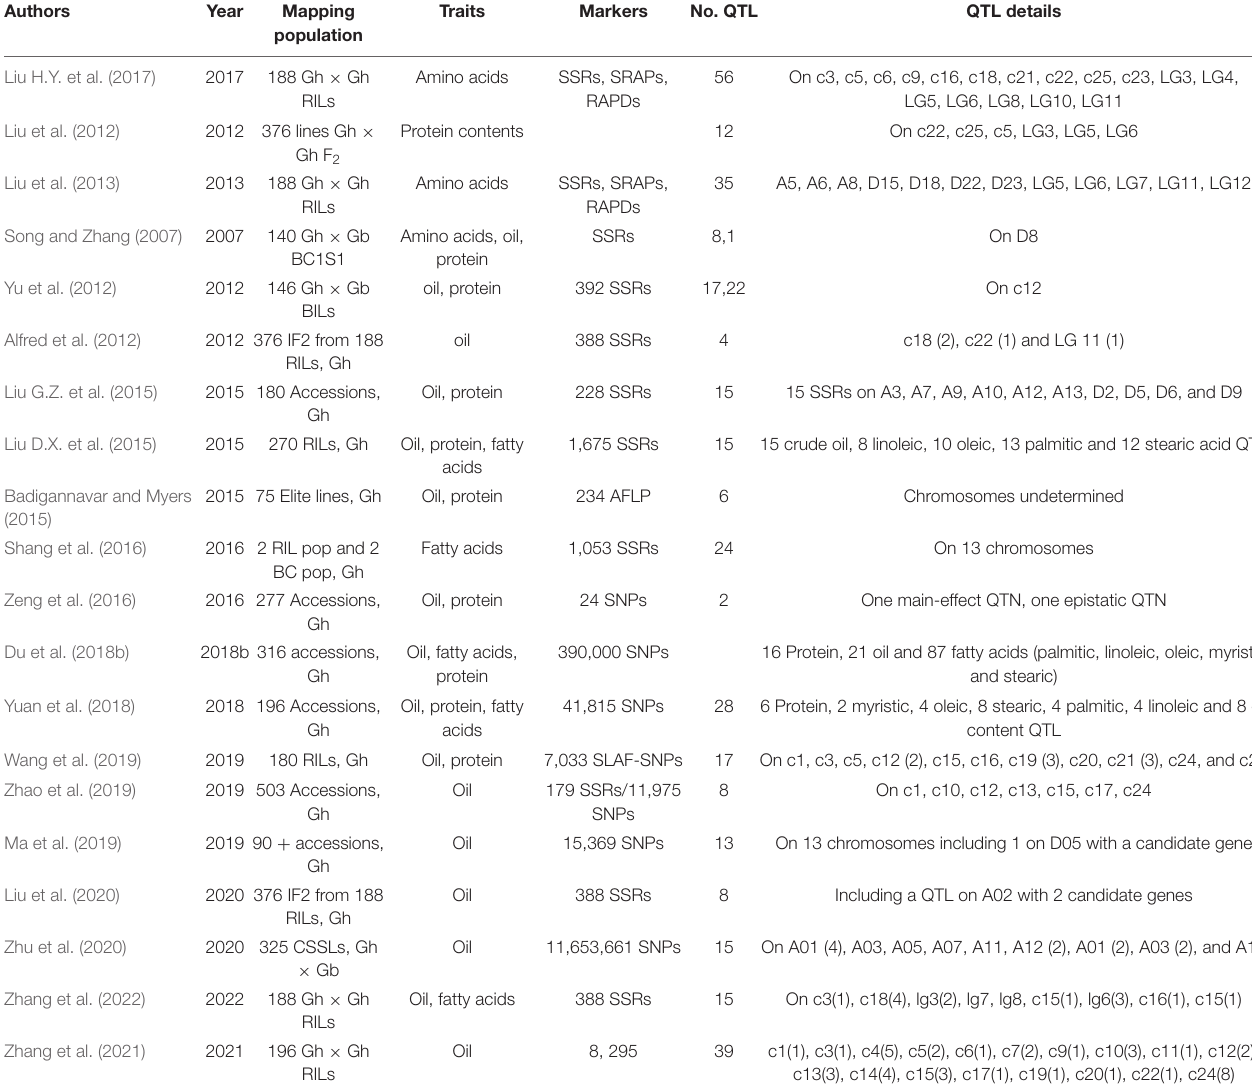
TABLE 1 | Quantitative trait loci (QTLs) mapped for cottonseed oil content and fatty